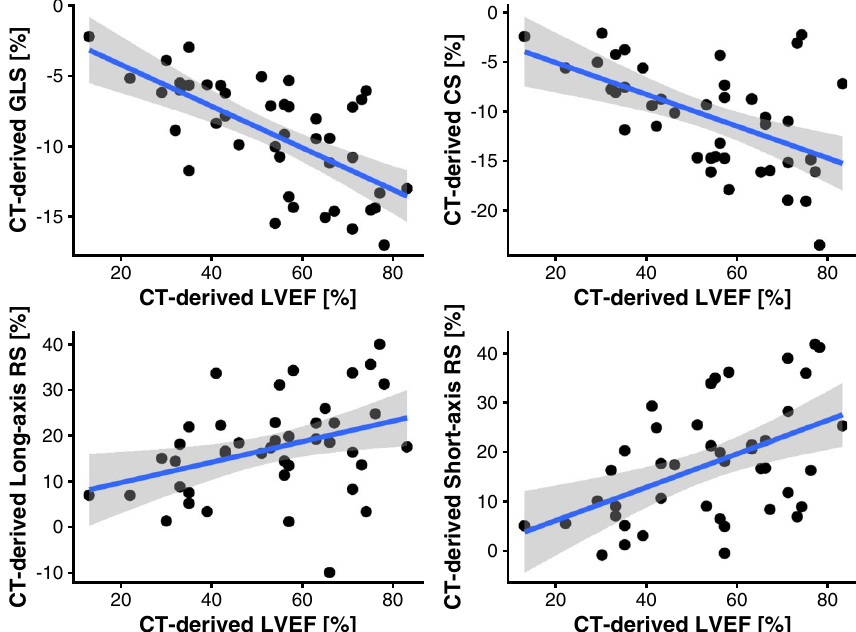
Figure 3. Scatterplot showing the correlation of CT-derived strain in different orientations and CT-derived LVEF. Pearson’s correlation coefficients for the different orientations are as follows: GLS: r = − 0.66 ( p < 0.001), CS: r = − 0.53 ( p < 0.001), long-axis RS: r = 0.37 ( p = 0.02), short-axis RS: r = 0.49 ( p < 0.001; GLS, global longitudinal strain; CS, circumferential strain; RS, radial strain; LVEF, left ventricular ejection fraction).